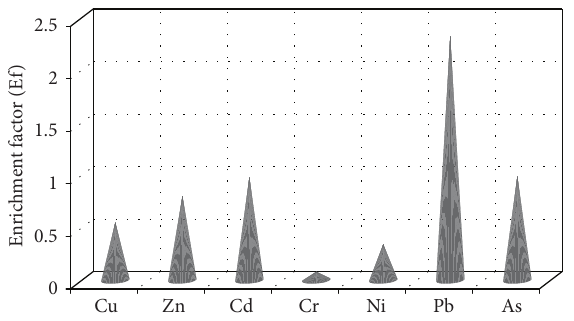
F 2: Enrichment factors for metals in the soil